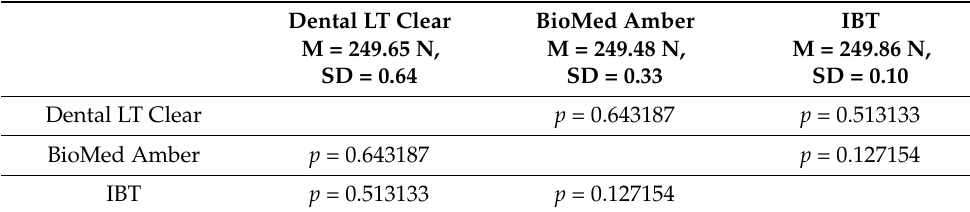
Table 8. Force differences in the Tukey highly significant difference test (M—mean; SD—standard deviation; p — p -value).